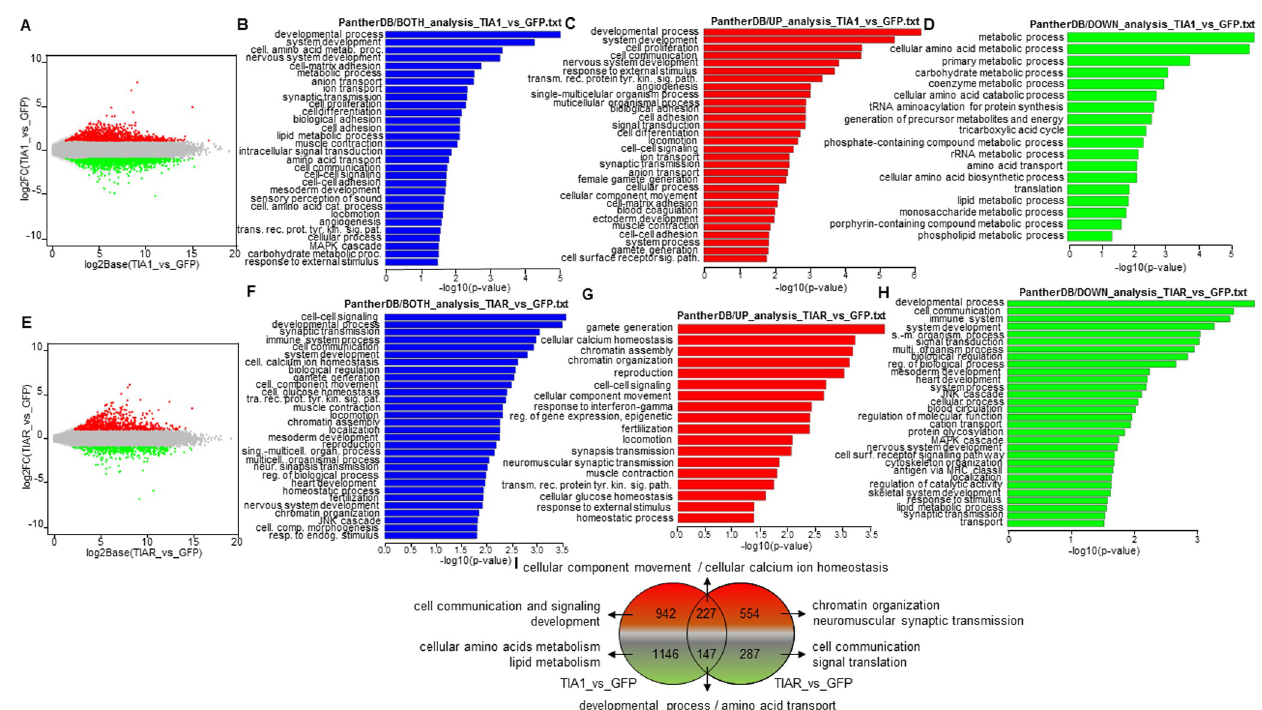
Fig 2. Gene Ontology (GO) analysis of differentially expressed genes (DEGs) in GFP-, GFP-TIA1b-, and GFP-TIARb-expressing FT293 cells. (A-H) Top categories of biological processes associated with DEGs. (A and E) MA plot representations of the distributions of up- (spots in red) and down- (spots in green) expressed genes (-1 � log fold change � 1; FDR < 0.05) in the corresponding combinations indicated in A and E panels, respectively. (B-D and F-H) Histograms of the distributions of up- and down-regulated genes (B and F), only up-regulated genes (red in C and G) and only down-regulated genes (green in D and H) in the corresponding combinations using the GO PANTHER database ( P < 0.05). (I) Venn diagram displaying numbers and GO enriched categories of DEGs in TIA1- and TIAR-expressing FT293 cells compared with control (GFP-expressing FT293 cells).